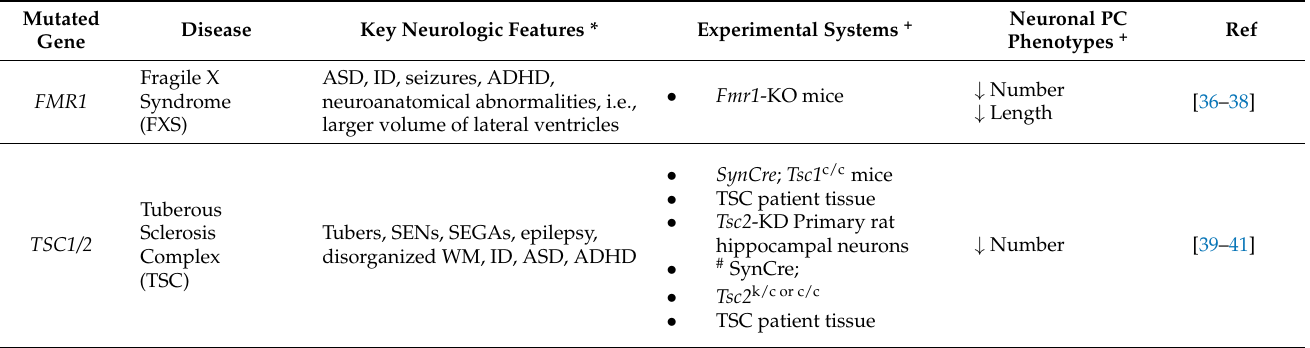
Table 1. Primary cilia phenotypes in neurodevelopmental disorders discussed in this